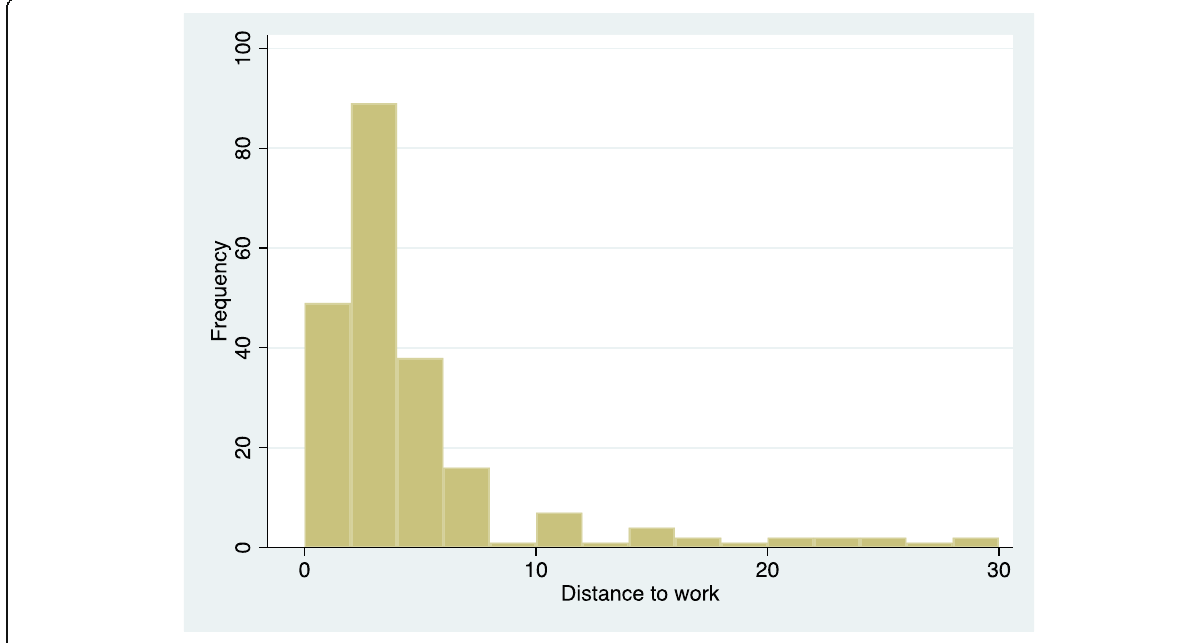
Fig. 1 Frequency distribution over distance to work for those that